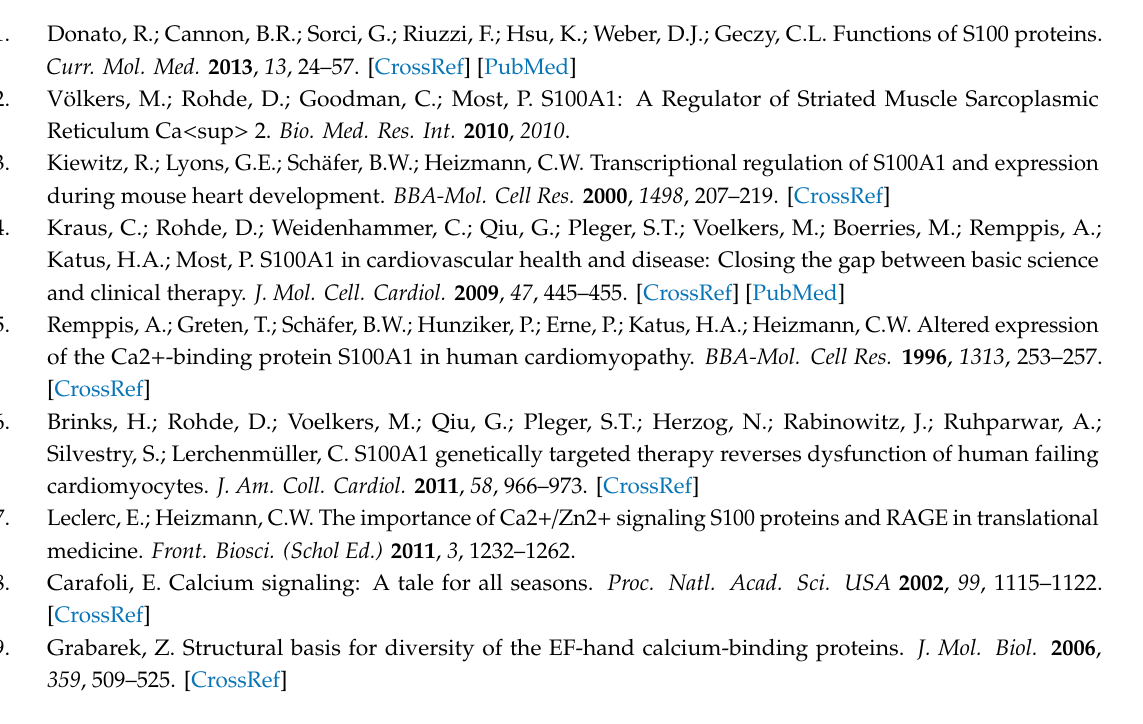
Figure S1: Approximations of Root mean square deviation (RMSD) of each systems of both simulation. RMSDs of Apo-crystal (black), Holo-S100A1 (red) and experiment of free entry of Ca 2 + ions into bulk (blue), are showing a plateau after half of the simulation, Figure S2: Calculations of Root mean square fluctuation (RMSF) of each system which is listed in Table 1. RMSFs in each system demonstrating same pattern till residue number ~40. Panel A represents RMSF of apo-S100A1 during simulations. Panel B depicts the RMSF of holo-S100A1 and Panel C corresponds to system of free entry of Ca-ions in the bulk